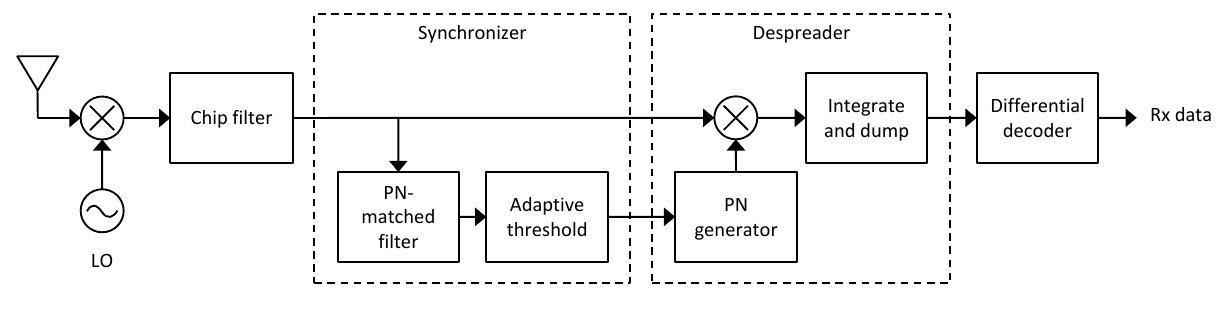
Figure 7. Simplified block diagram of the DS-CDMA receiver implemented on the USRP N210 and GNU Radio